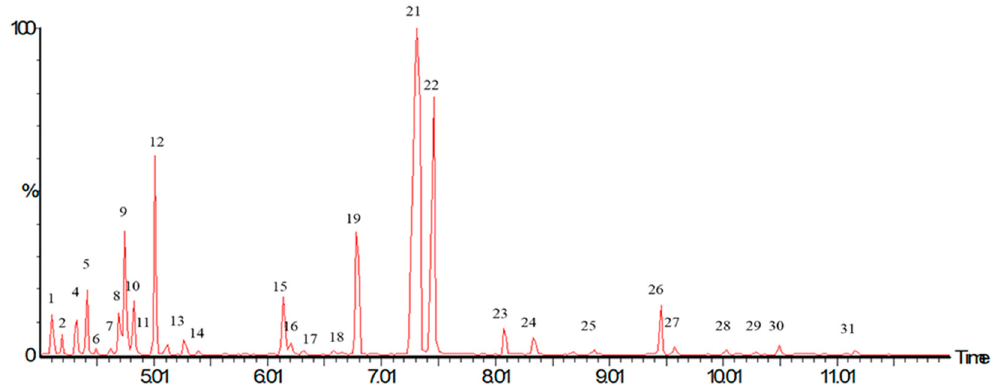
Figure 1. Chromatogram of Poliomintha longiflora essential oil obtained by hydrodistillation